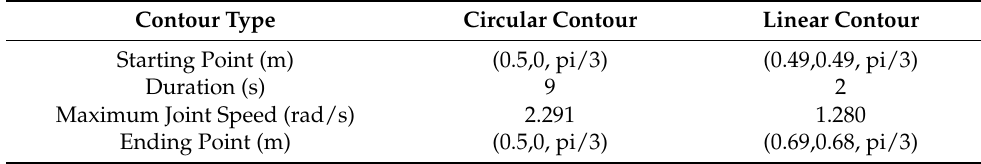
Table 1. Contour